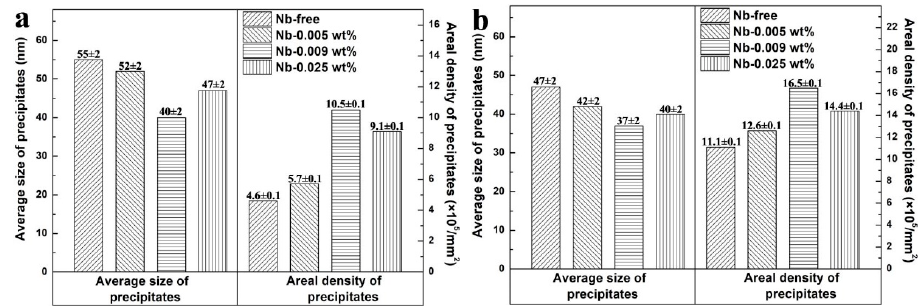
Figure 3. Average size and areal density of precipitates in ( a ) primary recrystallized sheet and ( b ) nitrided sheet .